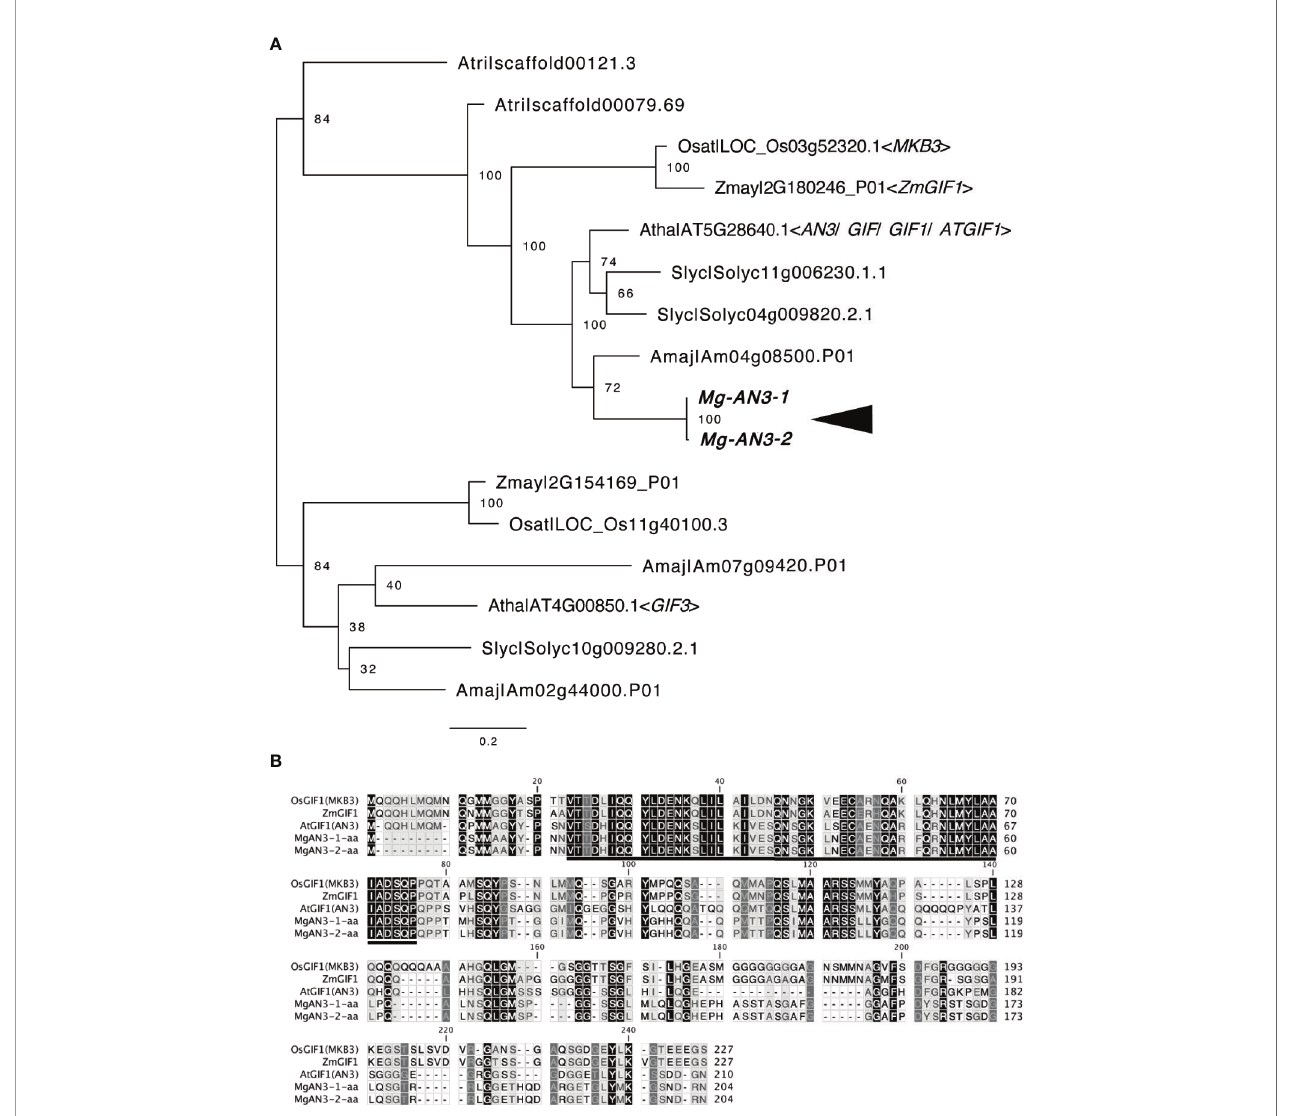
FIGURE 5 | Molecular characterisation of Mg-AN3 . (A) Partial ML phylogenetic tree of the GIF family. Bootstrap values are shown at the branches. Amaj, Antirrhinum majus ; Atha, Arabidopsis thaliana ; Atri, Amborella trichopoda ; Osat, Oryza sativa ; Slyc, Solanum lycopersicum ; Zmay , Zea mays. (B) Amino acid sequence alignment of the AN3 homologs Mg-AN3-1 , Mg-AN3-2 , AtAN3 ( Arabidopsis thaliana AT5G28640.1), ZmAN3 ( Zea mays : Zhang et al., 2018), and OsAN3 ( Oryza sativa : Shimano et al.,